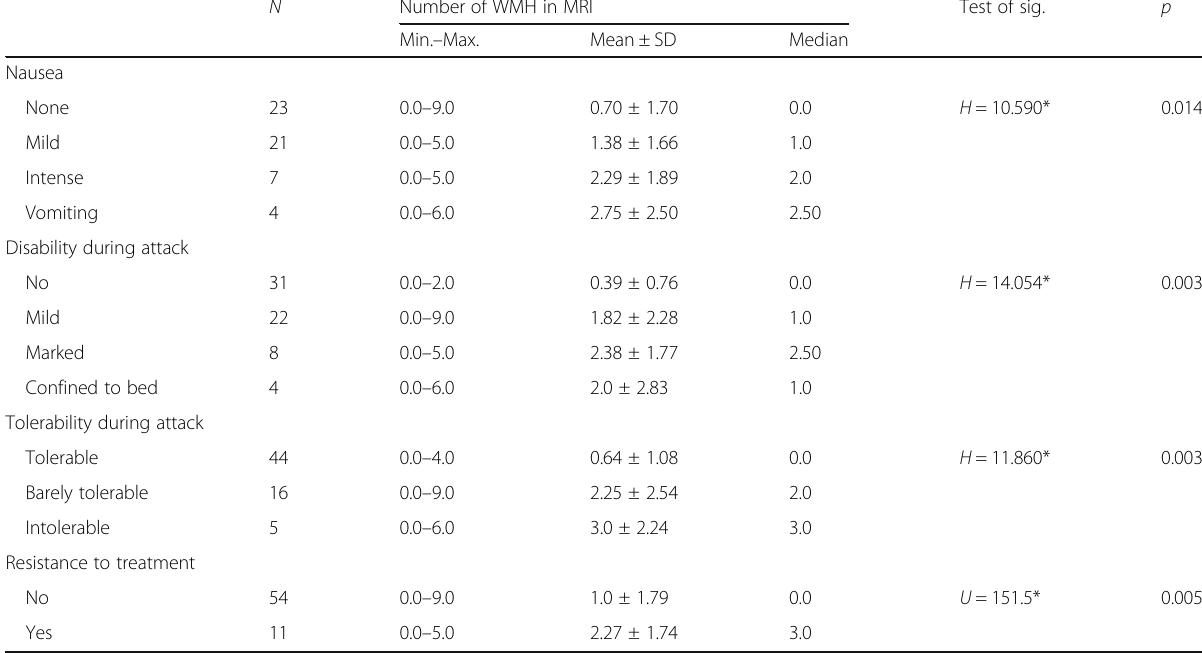
Table 5 Number of WMH and MIGSEV parameters (continued) N Number of WMH in MRI Test of sig.